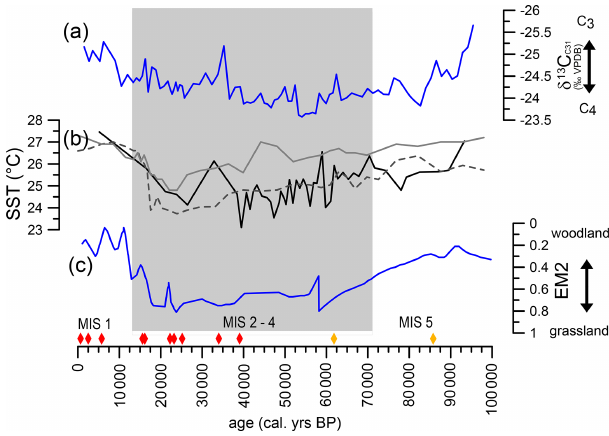
Figure 3. Climatic patterns at orbital timescales recorded in GeoB20616-1. Panel (a) shows down-core δ 13 C values of the C 31 n - alkane in per mill VPDB of GeoB20616-1 as indicators of shifts in vegetation type (C 3 vs. C 4 ). Panel (b) shows SST (sea surface tem- peratures) recorded by G. ruber Mg / Ca (black line) in GeoB20616- 1 as well as offshore Limpopo River (core MD96-2048) SST calcu- (cid:48) (gray line) (Caley lated from TEX 86 (dashed line) and from U K 37 et al., 2011). Panel (c) shows Limpopo vegetation endmember EM2 from Dupont et al. (2011). The diamonds indicate C 14 dates (red) and δ 18 O tie points